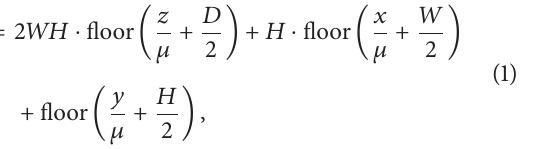
in the array is one-bit Boolean data item to indicate the voxel’s existence. Such approach facilitates access between neighboring